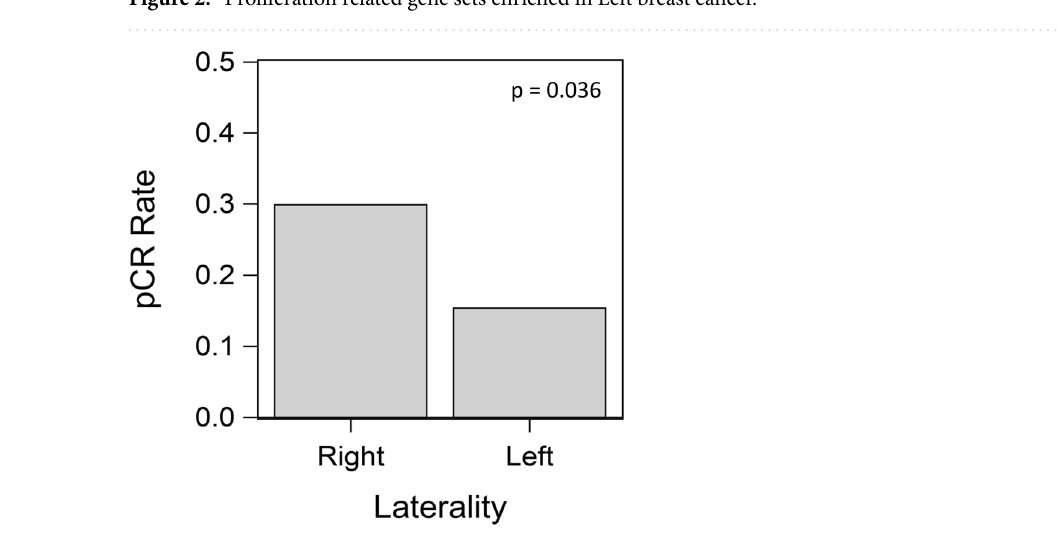
Figure 3. Pathological Complete Response (pCR) in left and right sided breast